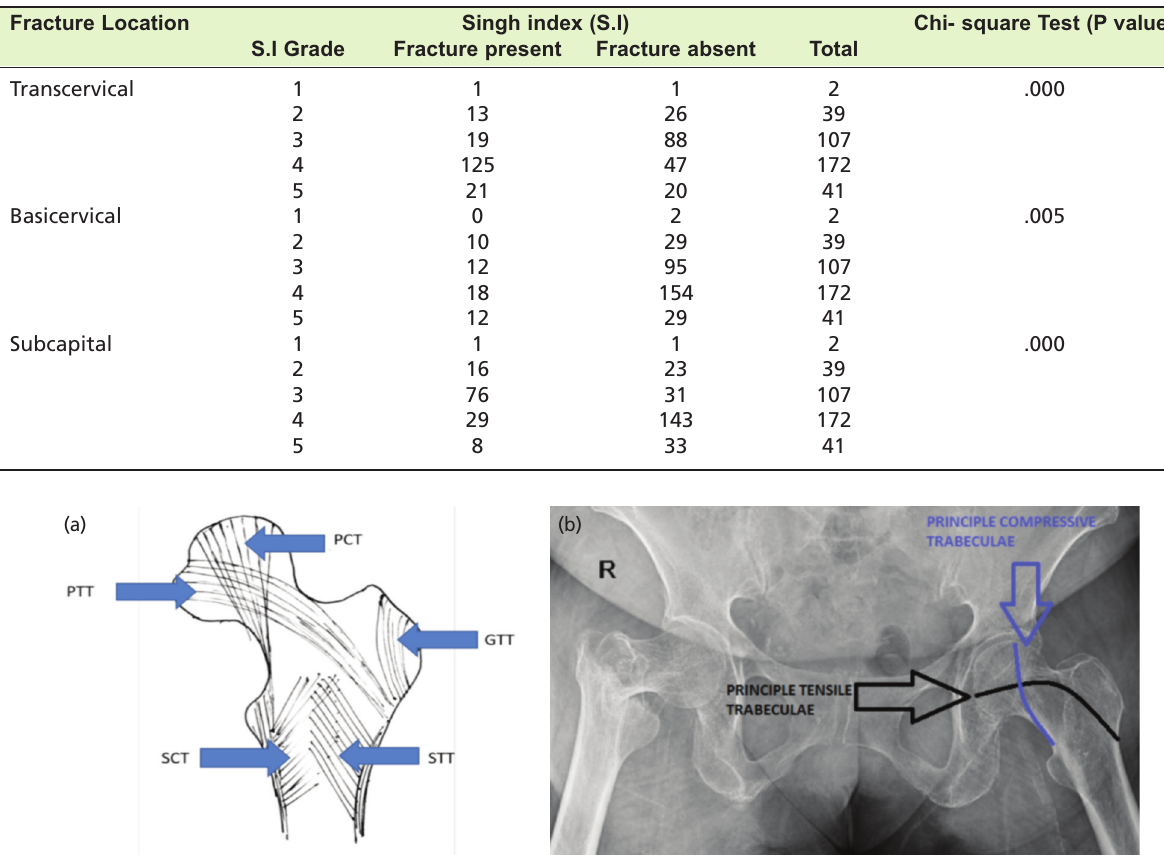
(a) Pictorial depiction of proximal femur trabecular pattern (b) Pelvis radiograph depicting the trabecular pattern of proximal Fig. 1: femur.